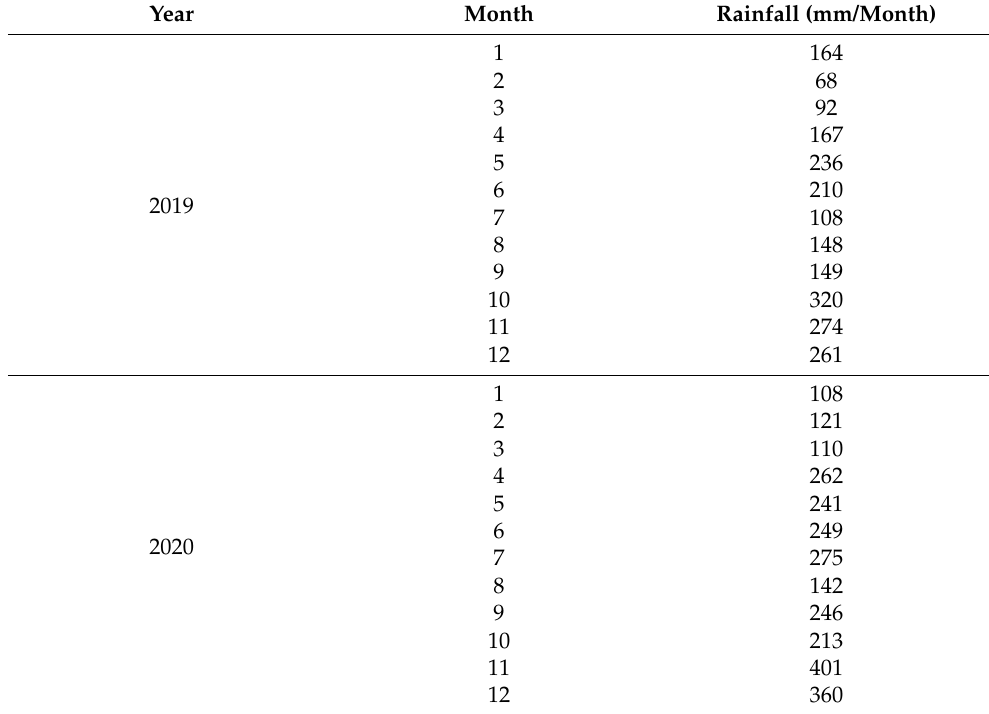
Table A3. Monthly rainfall in Peninsula Malaysia from 2019 to 2020